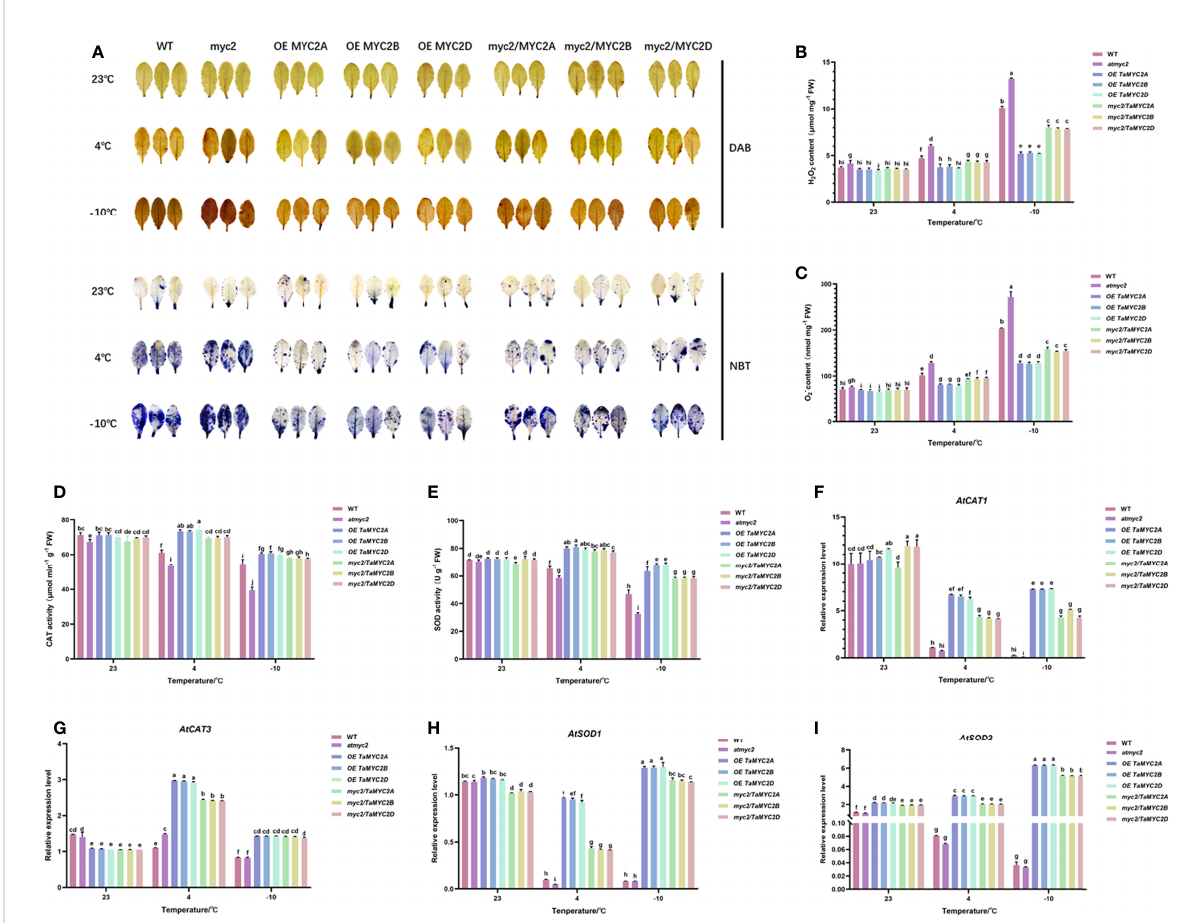
FIGURE 4 Histochemical staining and determination of ROS content and antioxidant enzymes in WT, atmyc2 mutants, and transgenic Arabidopsis under low temperature stress. (A) DAB (yellow) and NBT (blue) staining of the leaves under cold stress. (B, C) H 2 O 2 and O (cid:129) − 2 content determination. (D, E) Determination of CAT and SOD activity. Expression of (F) AtCAT1 , (G) AtCAT3 , (H) AtSOD1 , (I) AtSOD2 in WT, atmyc2 mutants, and transgenic Arabidopsis under low temperature stress. The error lines were obtained from three biological replicates. The mean values of the experimental data were analyzed by one-way ANOVA analysis. The comparison method was the least signi fi cant difference (LSD), and the bar graphs with different letters indicated signi fi cant differences ( p <